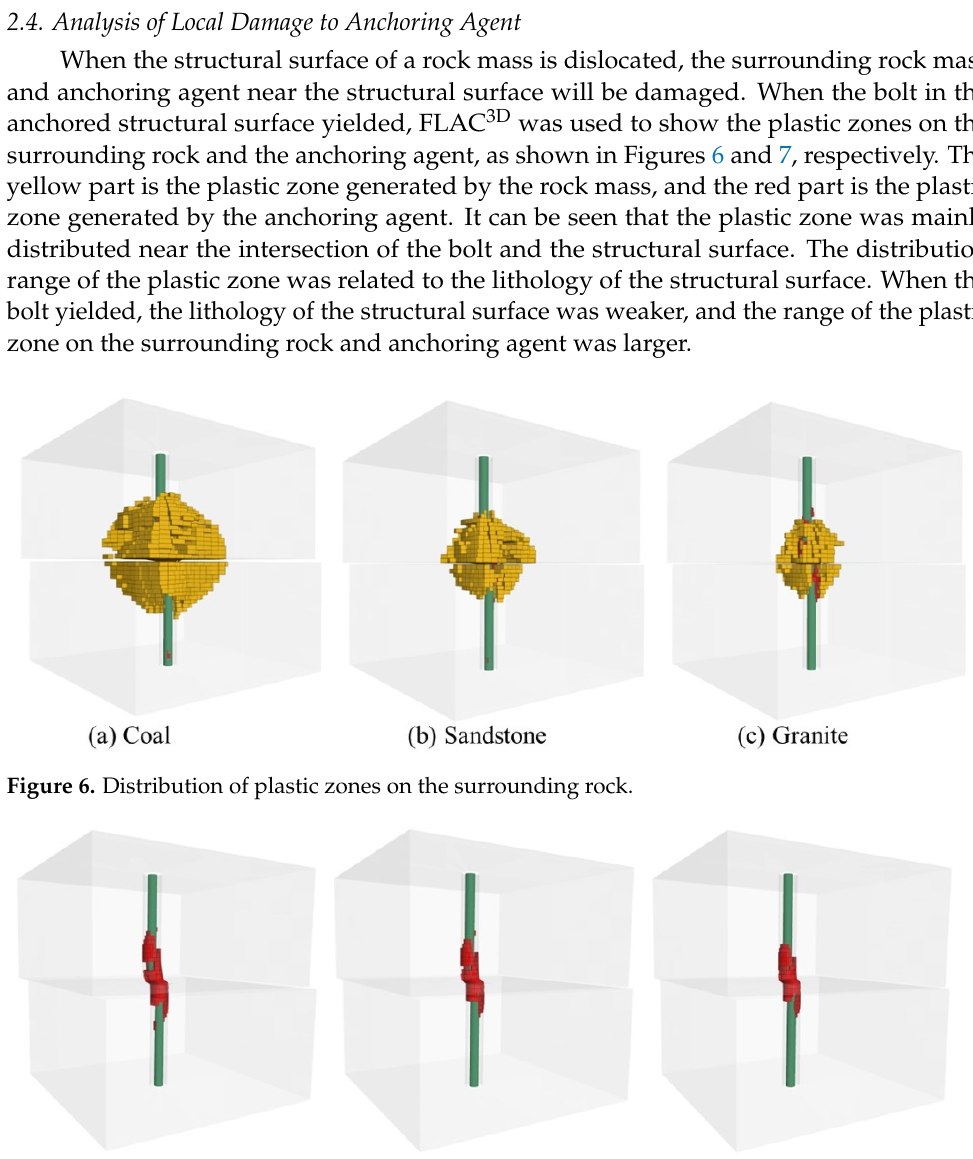
Figure 5. Curve of Von Mises equivalent stress–shear displacement of structural surface.